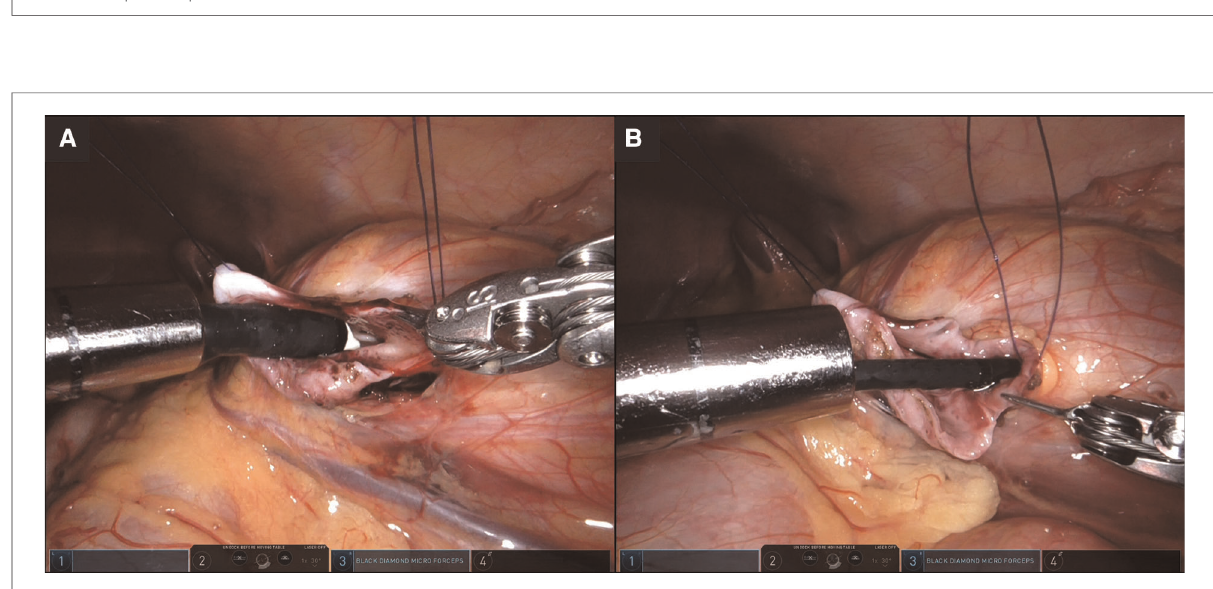
FIGURE 2 ( A ) Wide exposure of the pelvicalyceal system with two transabdominal hitch sutures. ( B ) Lower pole calyx with narrow opening (arrow) identi fi ed under the laparoscopic view with the assistance of robotic instrument.